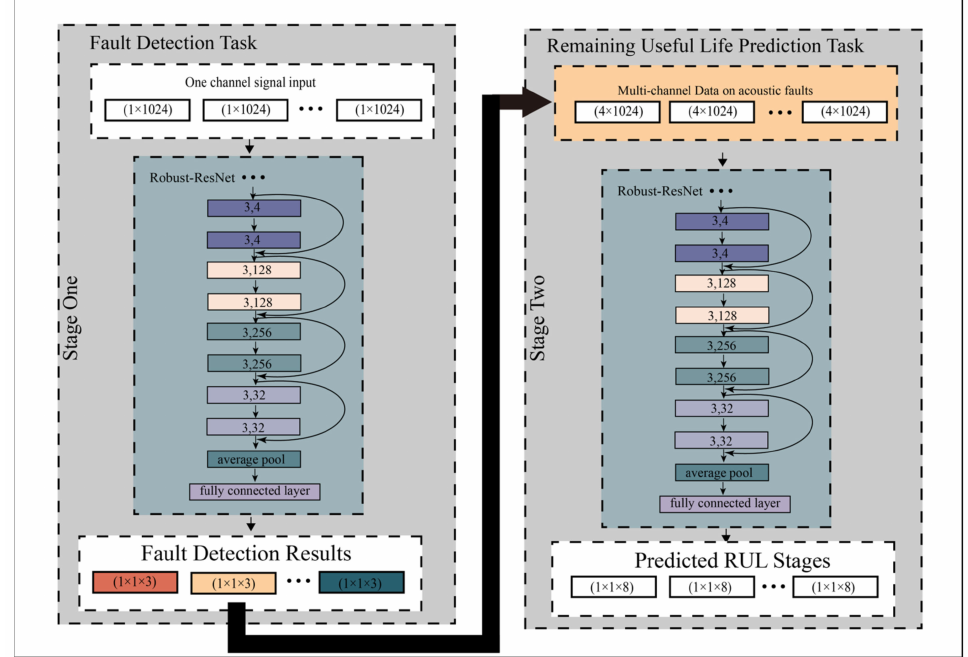
Figure 1. Methodological framework diagram of the proposed method. Our method is mainly based on Robust-ResNet implementation for two-stage tasks: fault detection and remaining useful life prediction. Robust-ResNet achieves robustness of the ResNet network using a small step factor h . The first-stage task is the fault detection using one-channel signals of 1 × 1024 collected from pump outlet pressure pulsation sensor. The samples with acoustic faults are then used in the second stage: remaining useful life prediction. Four-channel signals were used in the RUL prediction, including signals from the pump inlet pressure pulsation sensor, pump outlet pressure pulsation sensor, pump inlet side acceleration sensor and pump outlet side acceleration sensor. The size of the input tensor is 4 × 1024. For the RUL prediction stage in the figure, a sample length of 1024 is used as an example. Different sample lengths are compared in the actual